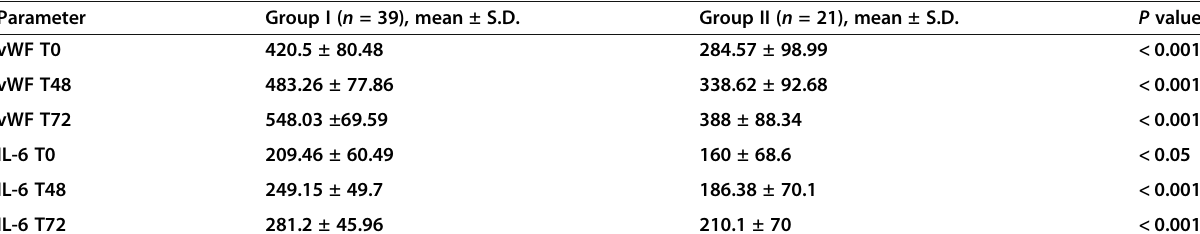
Table 3 Comparison between vWF and IL-6 different levels in ARDS and non ARDS patients p < 0.05 is considered statistically significant Parameter Group I ( n = 39), mean ± S.D. Group II ( n = 21), mean ± S.D.